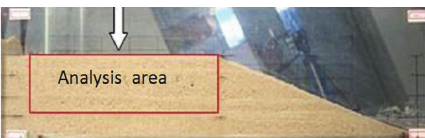
Figure 6: The analysis area of displacement